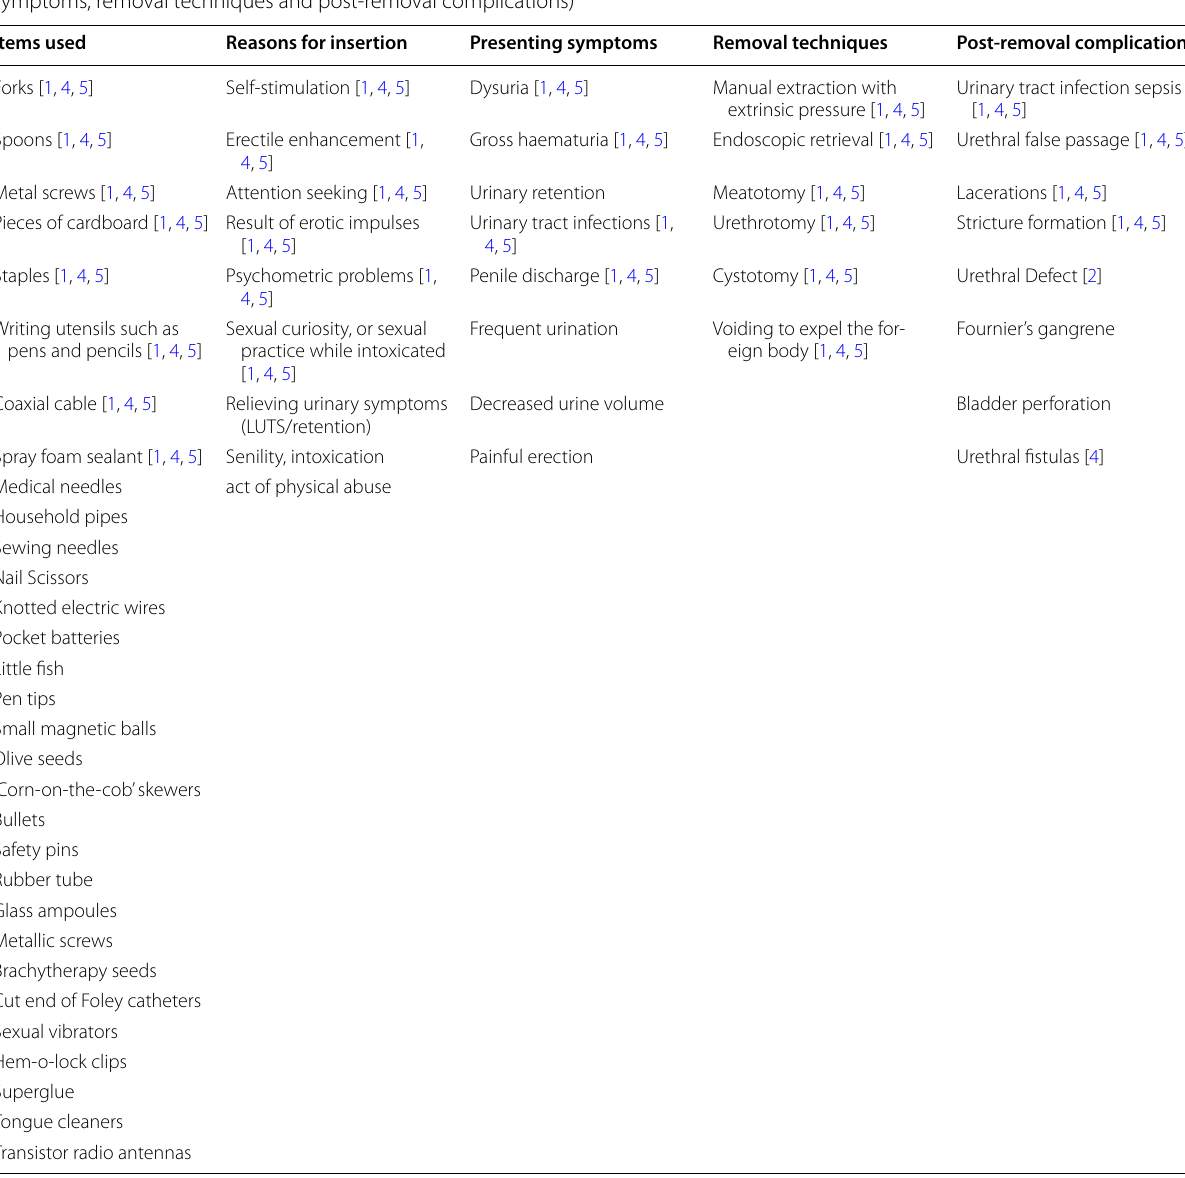
Table 1 Summary of urethral foreign bodies cases according to the available literature (items used, reasons for insertion, presenting symptoms, removal techniques and post-removal